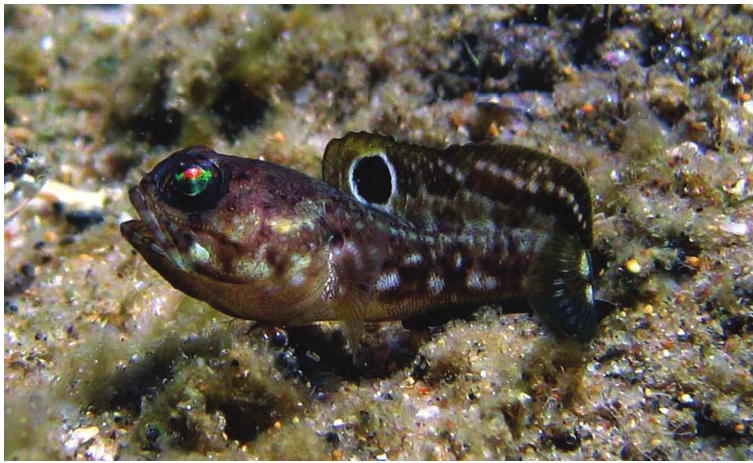
Figure 14. Opistognathus cuvierii , 80 mm TL estimated, Ilha dos Frades, Baía de Todos os Santos, Bahia, Brazil. Photograph by Cláudio L. S. Sampaio.